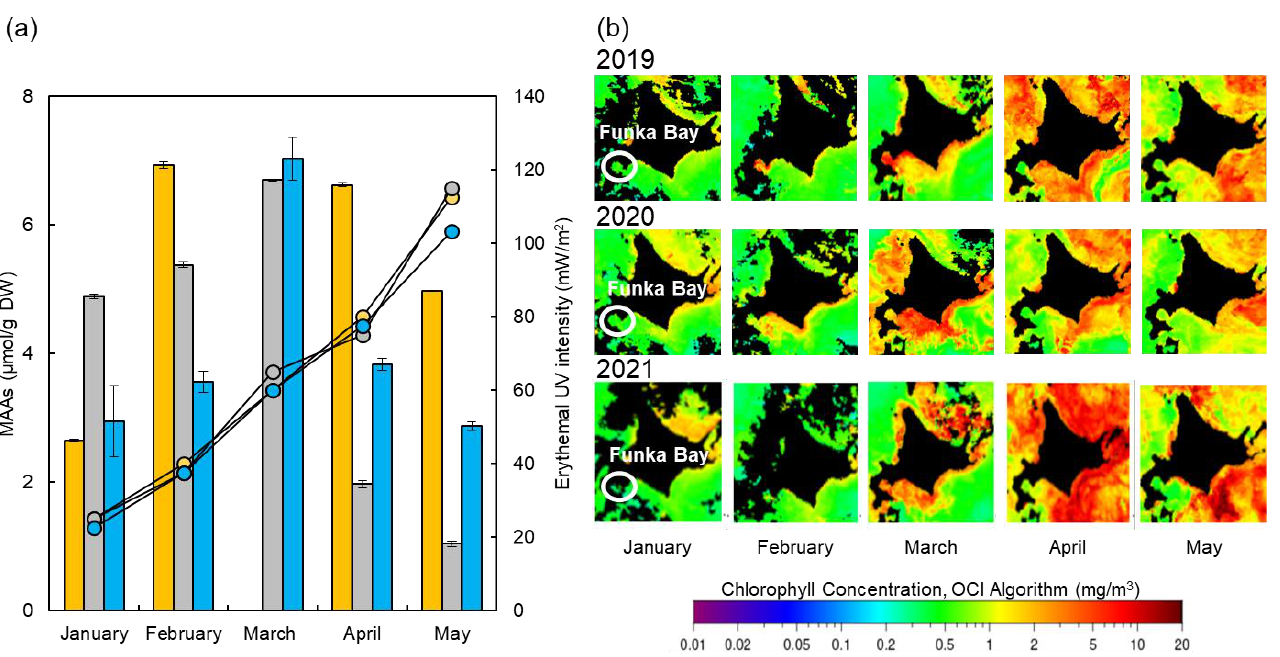
Figure 4. Monthly mean MAA contents, daily maximum erythemal UV intensities, and chlorophyll concentrations in 2019, 2020, and 2021. ( a ) MAA content and erythemal UV intensity. The orange bar and line show MAA content and erythemal UV intensity in 2019; the gray bar and line show MAA content and erythemal UV intensity in 2021; the blue bar and line show MAA content and erythemal UV intensity in 2021. ( b ) Chlorophyll concentrations. The sampling place was Usujiri, at the entrance to Funka Bay. These data were obtained from JMA and NASA’s Ocean Color WEB. All data were recorded in 2019 – 2021.